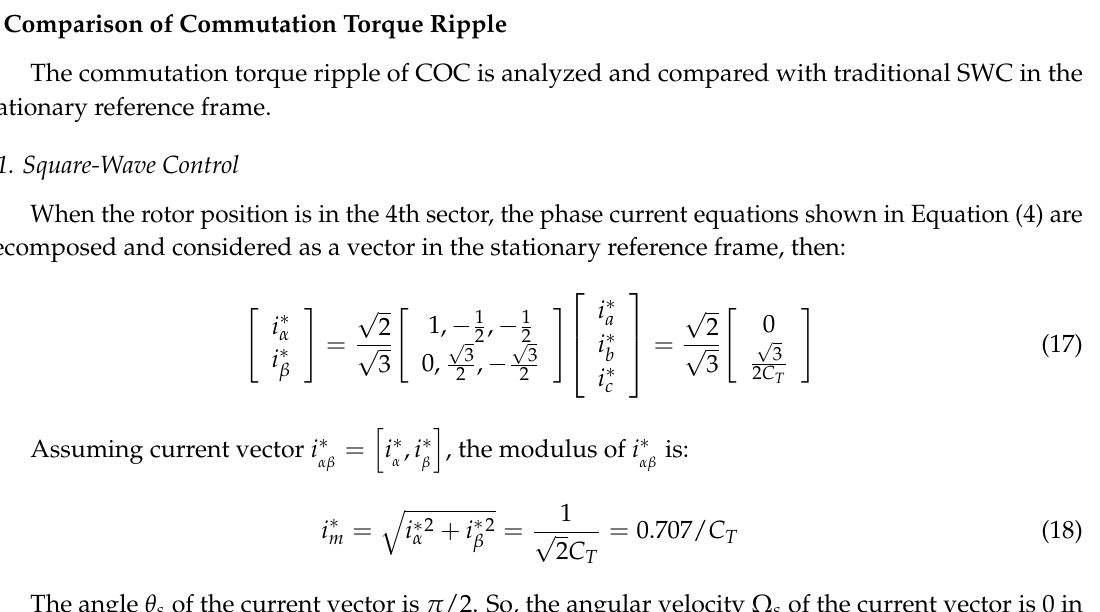
Figure 2. The waveforms of current and back-EMF.